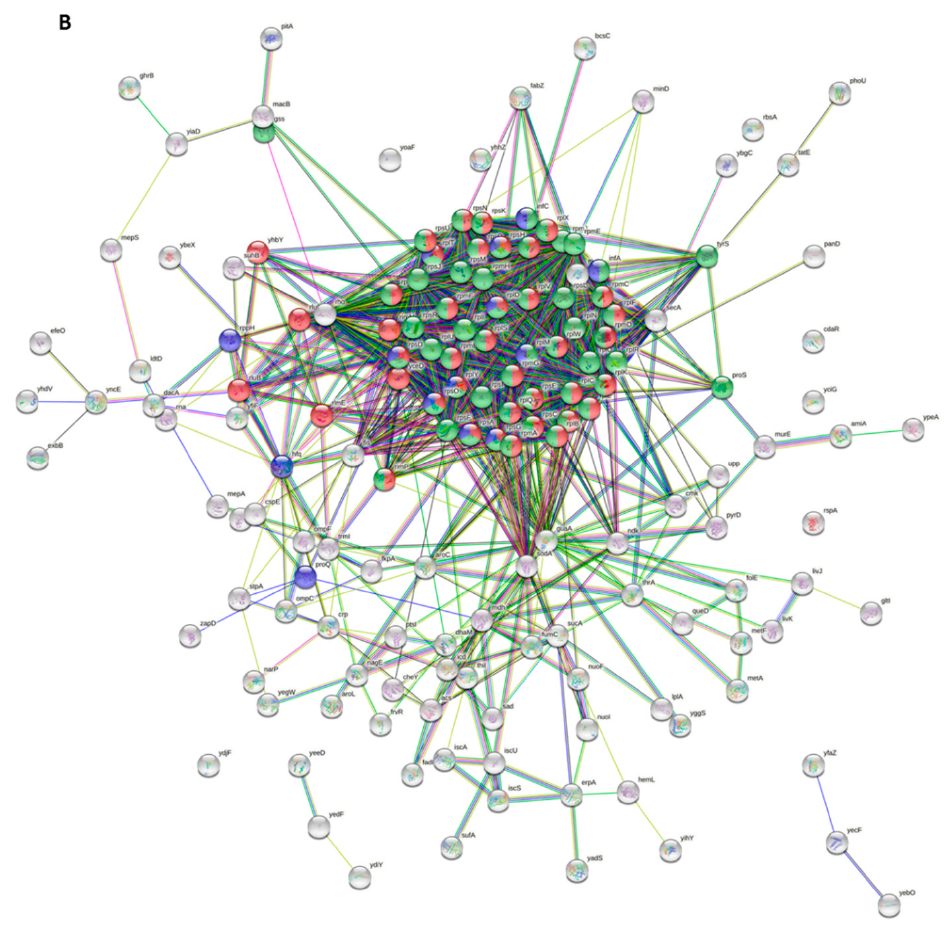
Figure 6. Protein–protein interaction networks of differentially abundant proteins. ( A , B ) The protein–protein interaction networks for increased ( A ) and decreased ( B ) differentially abundant proteins were generated using the STRING platform (https://string-db.org/). Abundance-increased proteins were involved in processes such as glycolysis, ATP metabolism, and coenzyme/small-molecule metabolism, for which proteins are represented in red, blue, and green, respectively. Abundance-decreased proteins were involved in ribosome biogenesis, post-transcriptional regulation of gene expression and peptide metabolism, and are indicated in red, blue, and green, respectively.